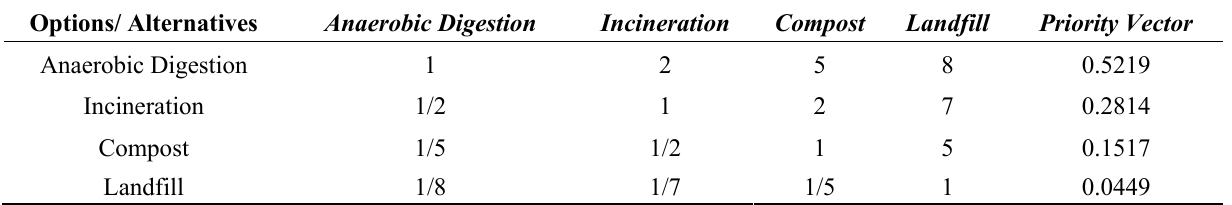
Table 5. Pairwise comparison matrix for the options with regards to sociocultural criteria.